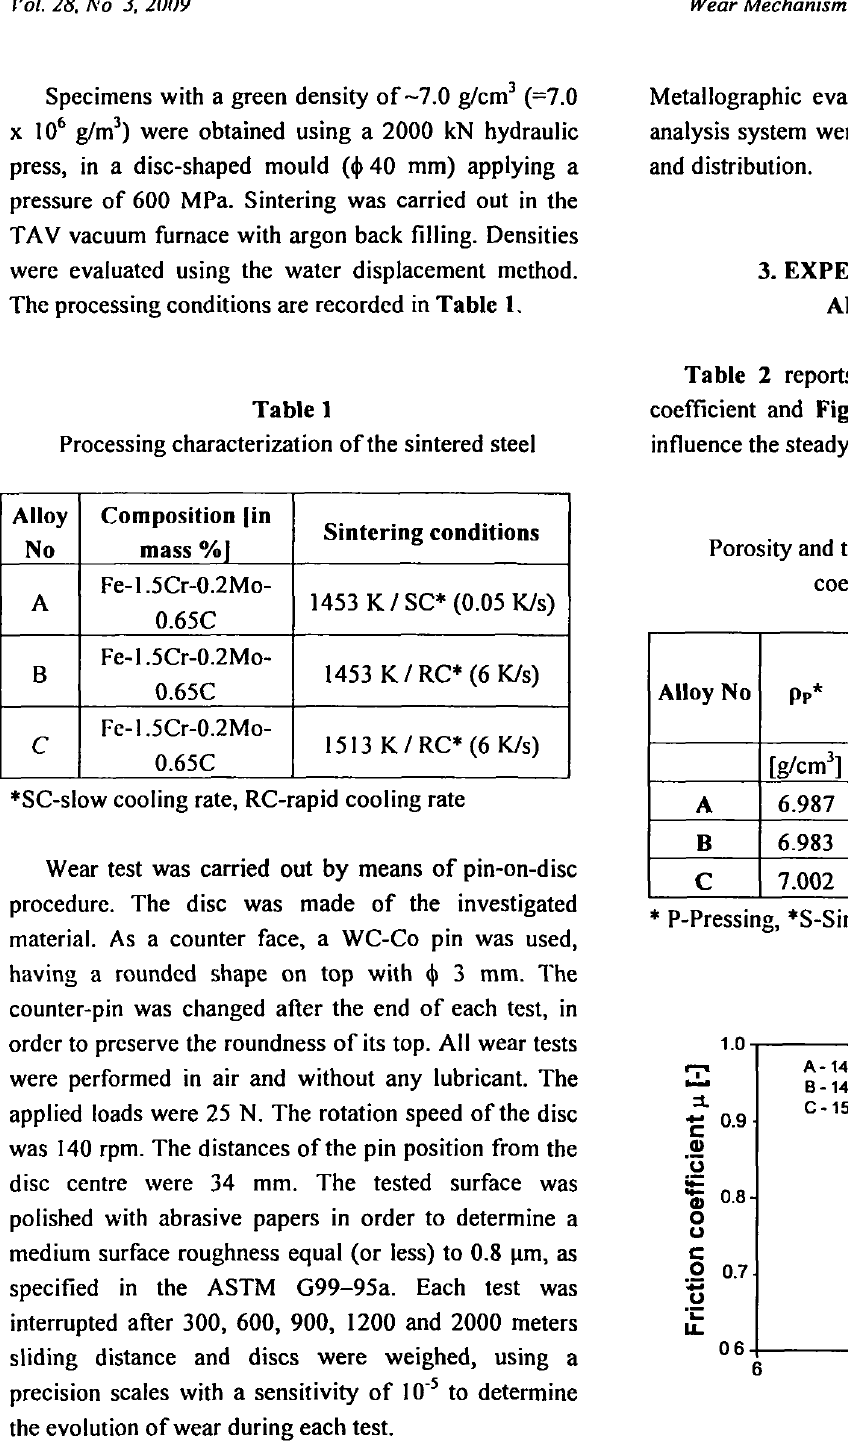
Fig. 1: Dependency of the steady-state value of friction coefficient on porosity The results show that the steady-state value of friction coefficient decreases with the increasing amount of porosity. Using traditional PM methods, cold